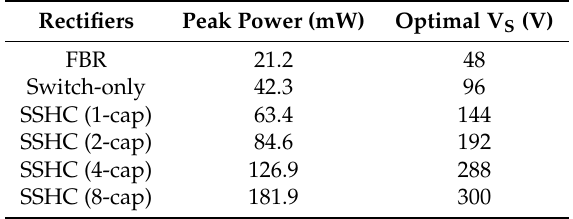
Table 5. Peak rectifier power for each rectification circuit and the corresponding optimal output